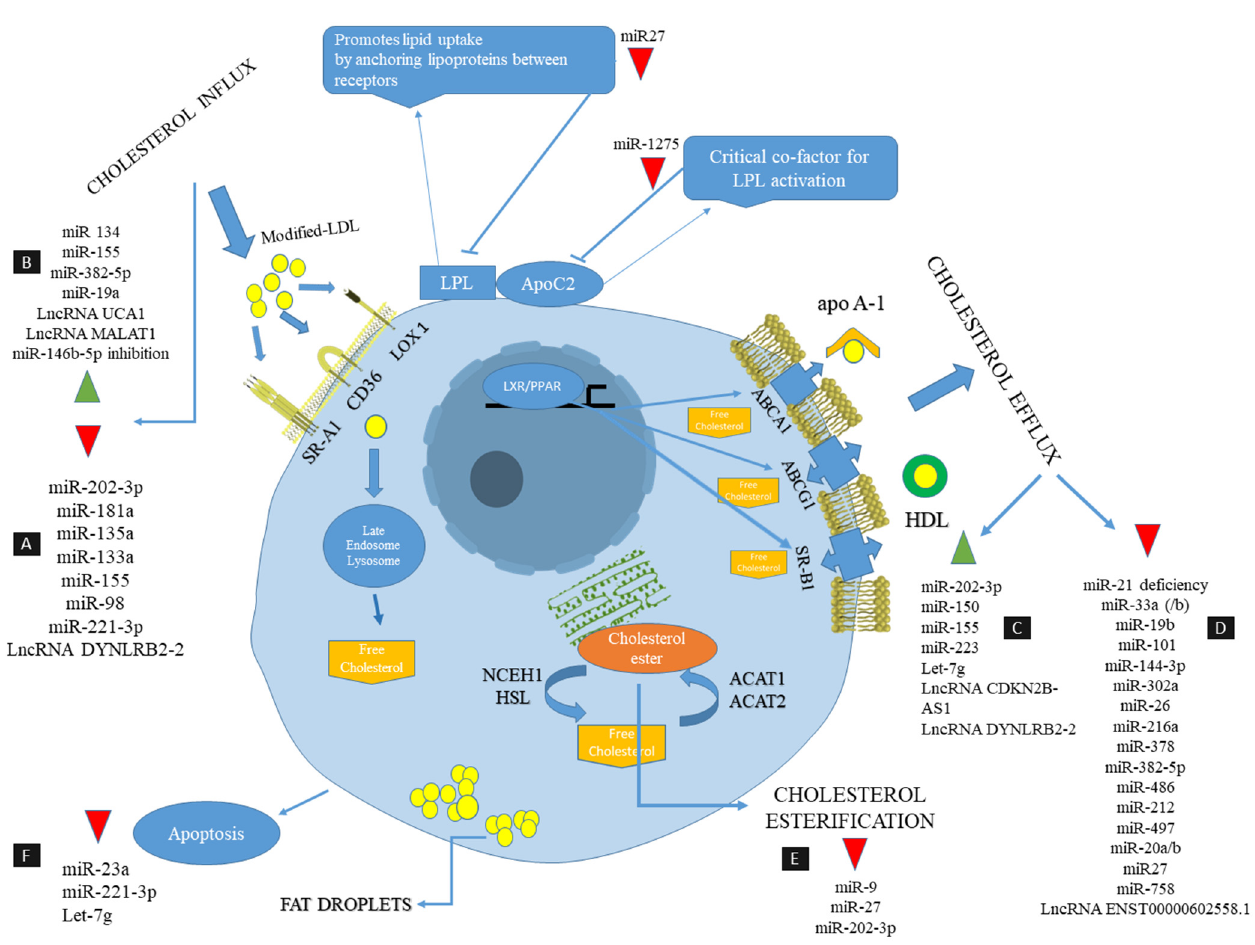
Figure 1. The mechanisms and molecules involved in cholesterol metabolism and homeostasis and the regulatory effects of Non-encoding RNAs are depicted in a foam cell. Cholesterol metabolism involves cholesterol influx, cholesterol esterification and cholesterol efflux, which ultimately leads to cholesterol homeostasis in the macrophage. Scavenger receptors SRA-1, CD36 and LOX1 are involved in oxLDL uptake. The gene expression of these receptors is downregulated in part A (see above); that is, non-encoding RNAs that have anti-atherosclerotic properties and are upregulated by part B ncRNAs, which are atherogenic and lead to lipid accumulation in macrophages. Cholesterol efflux is a pathway that transports excess free cholesterol from the cell, mainly via ABCA1, ABCG1, as well as SR-B1 transporters, leading to the formation of HDL